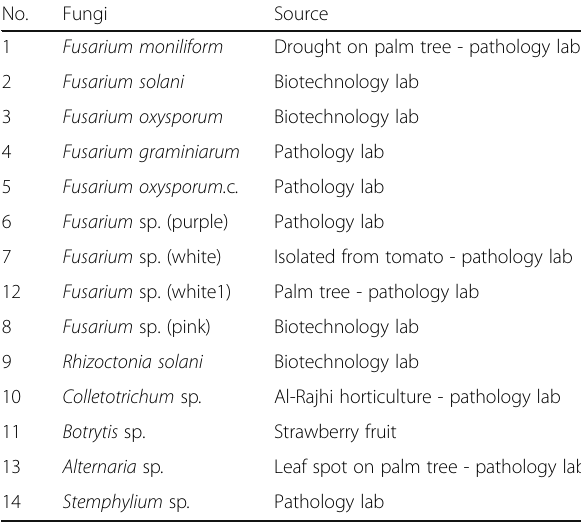
Table 2 Plant pathogenic fungi tested in the fungal